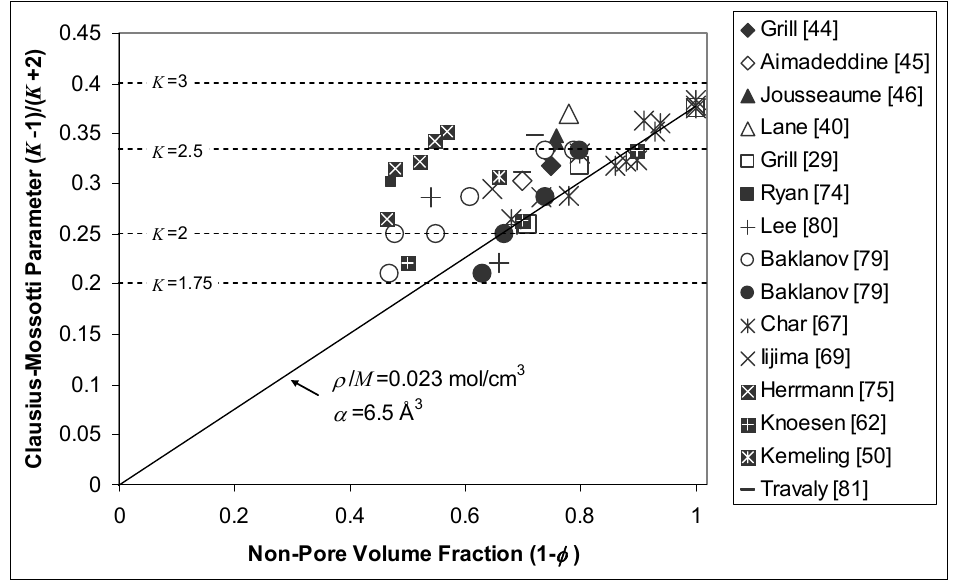
Figure 3. Clausius-Mossotti parameter ( K -1)/( K +2) plotted against non-pore volume fraction (1- φ ) for several PECVD and spin-on dielectric materials. The line represents the prediction of equation (4) assuming ρ/ M = 0.023 mol/cm 3 and α = 6.5 Å 3 , obtained by extrapolating data in Lin et al. [30] to an MSQ-like carbon-to-silicon ratio of